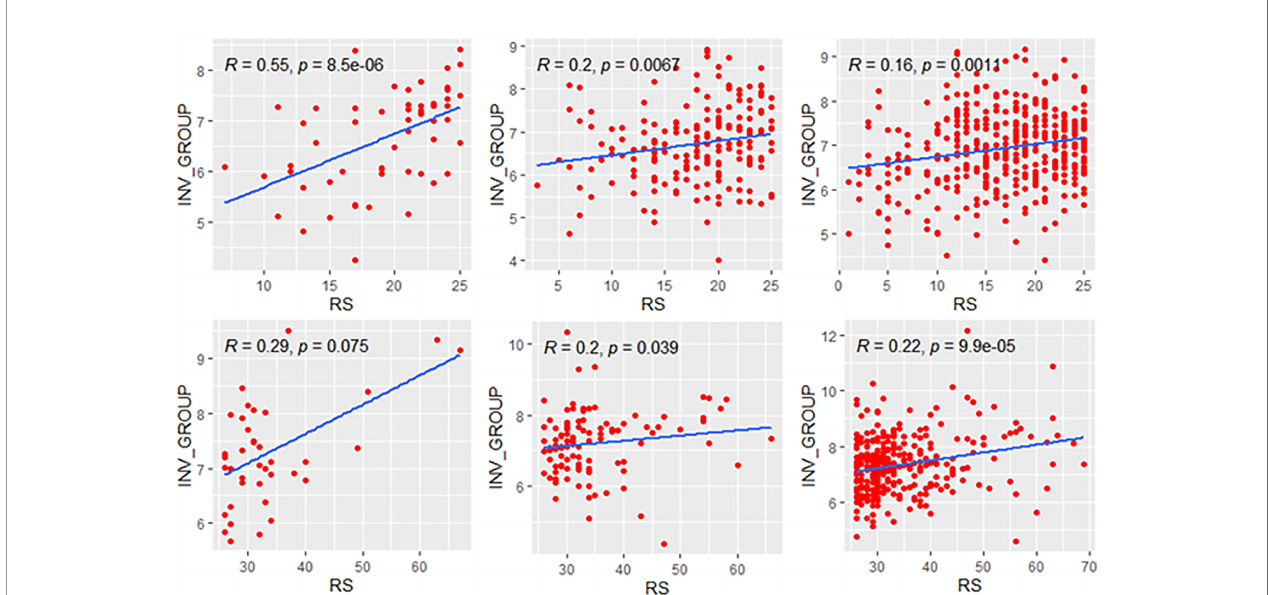
FIGURE 5 | Relationships of the RS with its invasion module. The upside and downside ranks showed the relationship in patients with RS ≤ 25 and RS >25, respectively. Groups A, B, and C were presented from left to right. RS, recurrence score; INV, invasion.